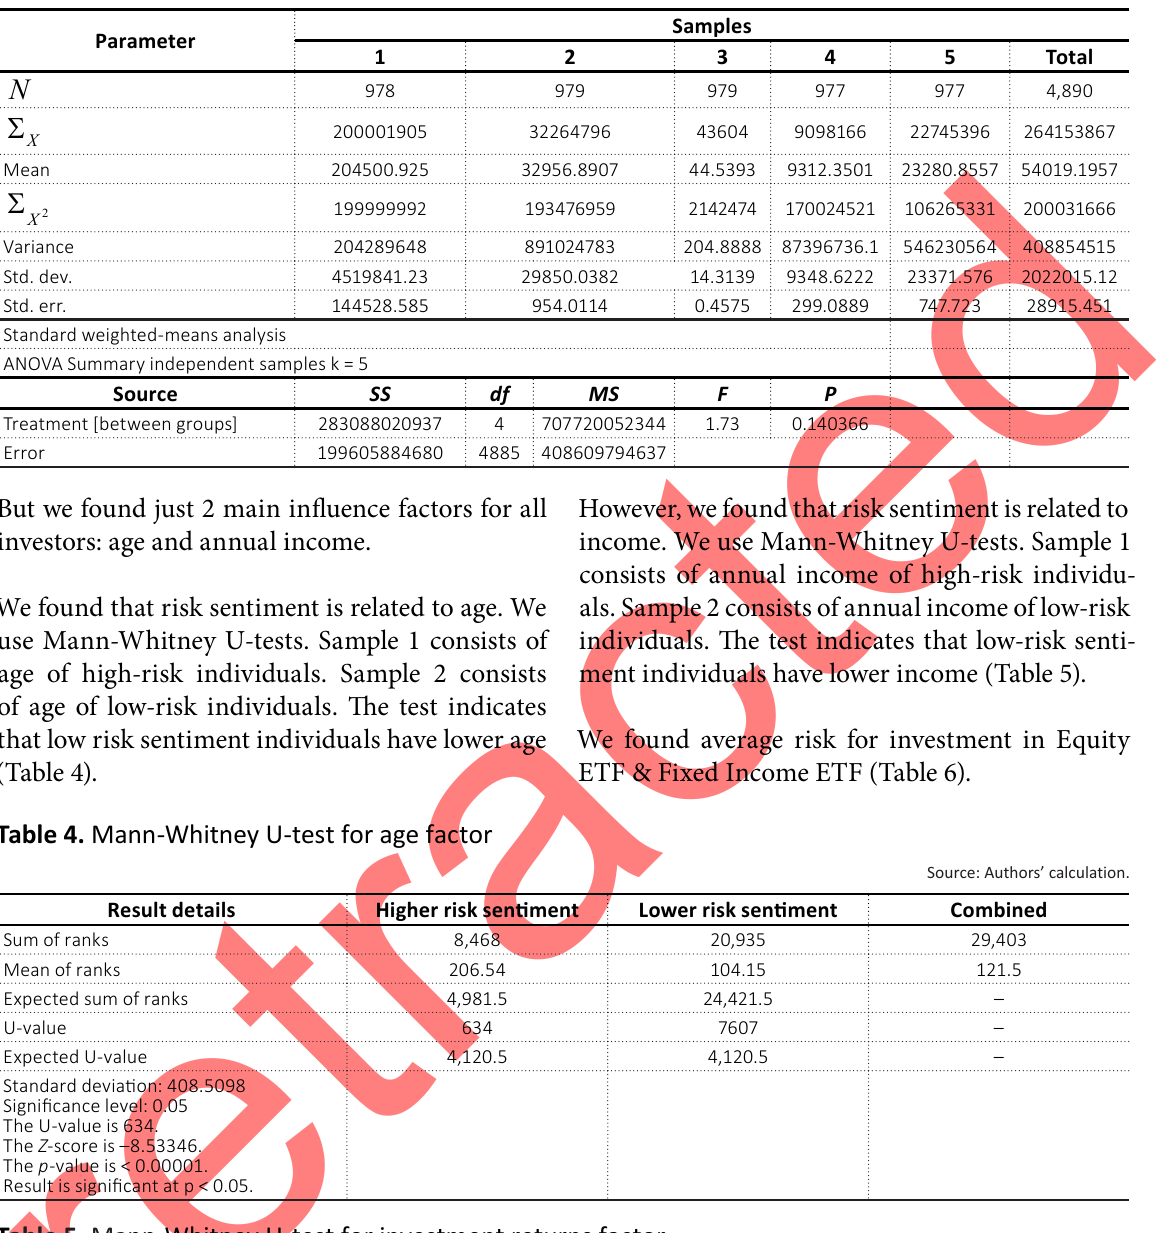
Table 5. Mann-Whitney U-test for investment returns factor